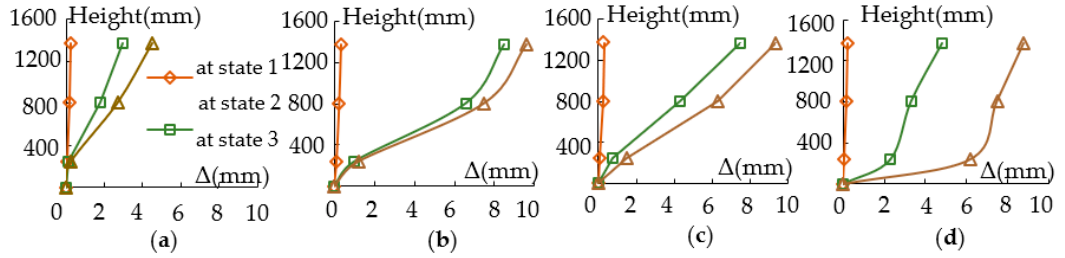
Figure 6. Lateral displacement of the walls: ( a ) W1; ( b ) W1S; ( c ) W2; ( d ) W3.